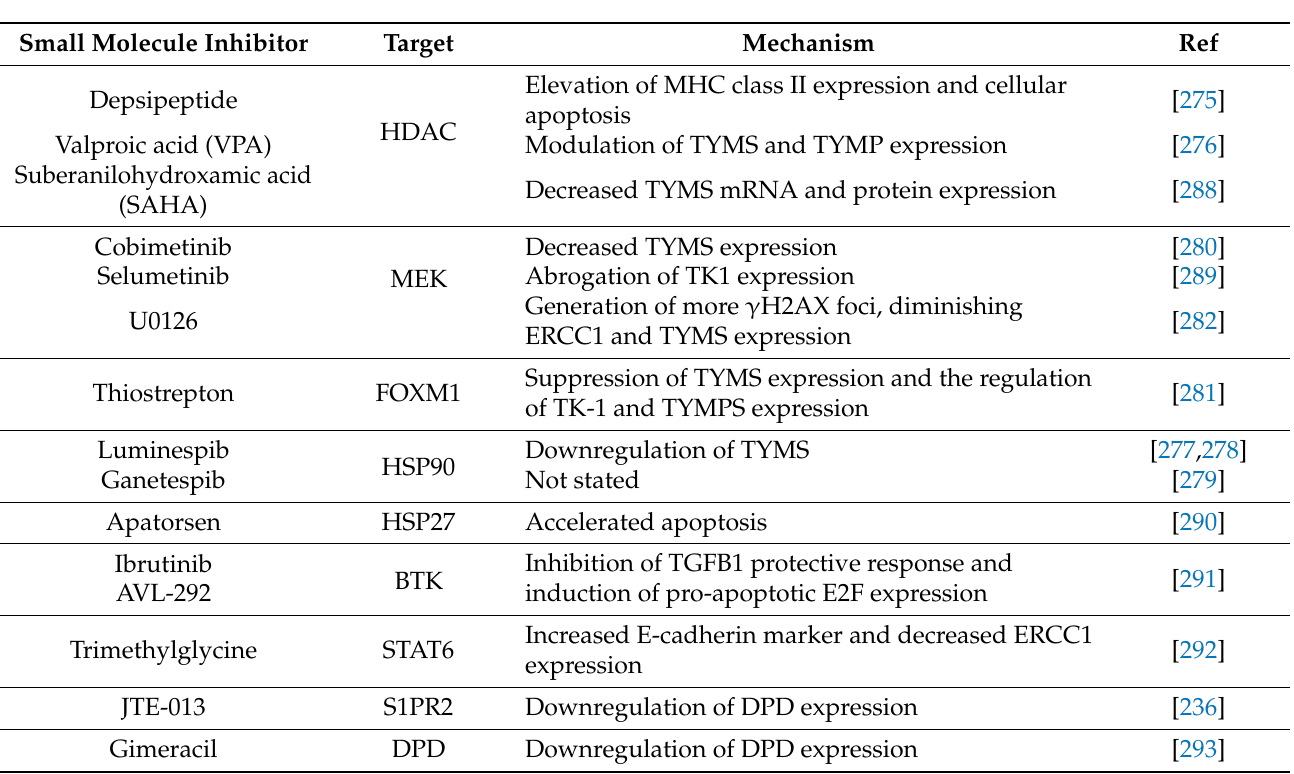
Table 4. Small molecule inhibitors that have been recently demonstrated to be capable in potentiating 5-FU chemosensitivity in colon cancer